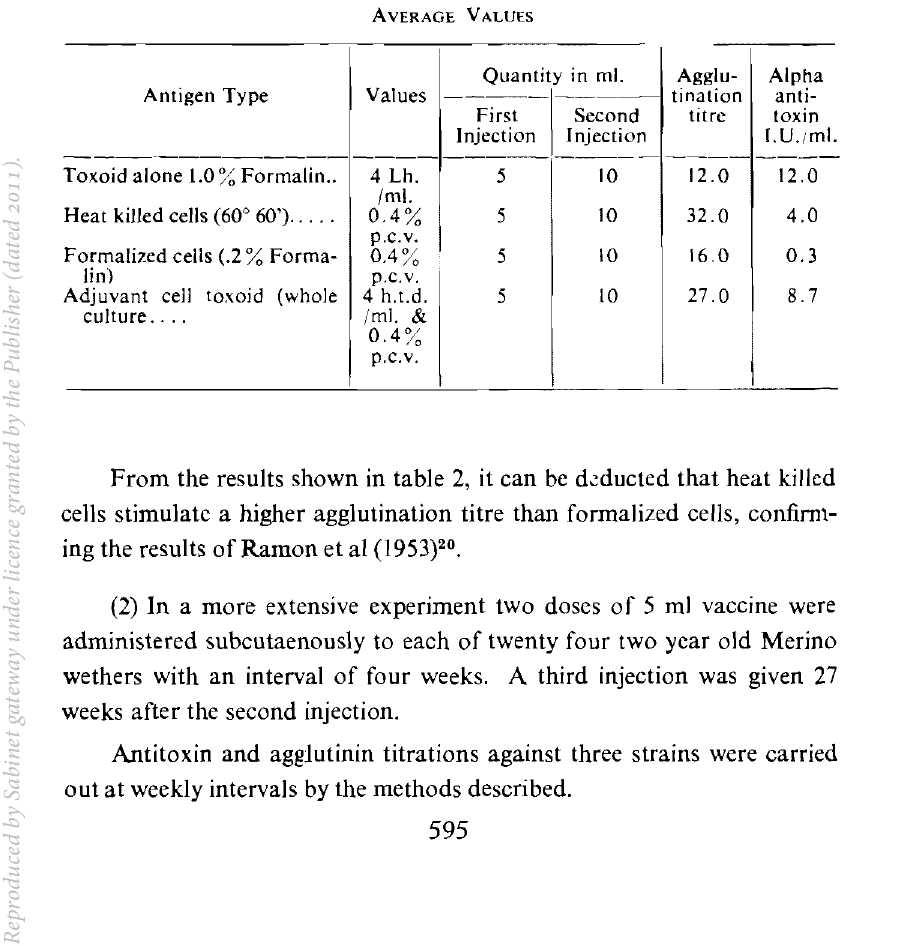
RESPONSE IN SHEEP TO VARIOUS